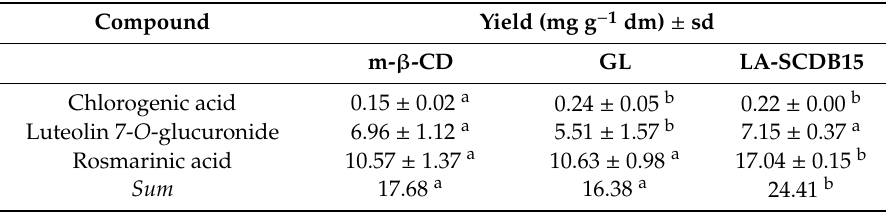
Table 5. Extraction yield in principal polyphenolic phytochemicals of S. fruticose , using LA-SCDB15, standard